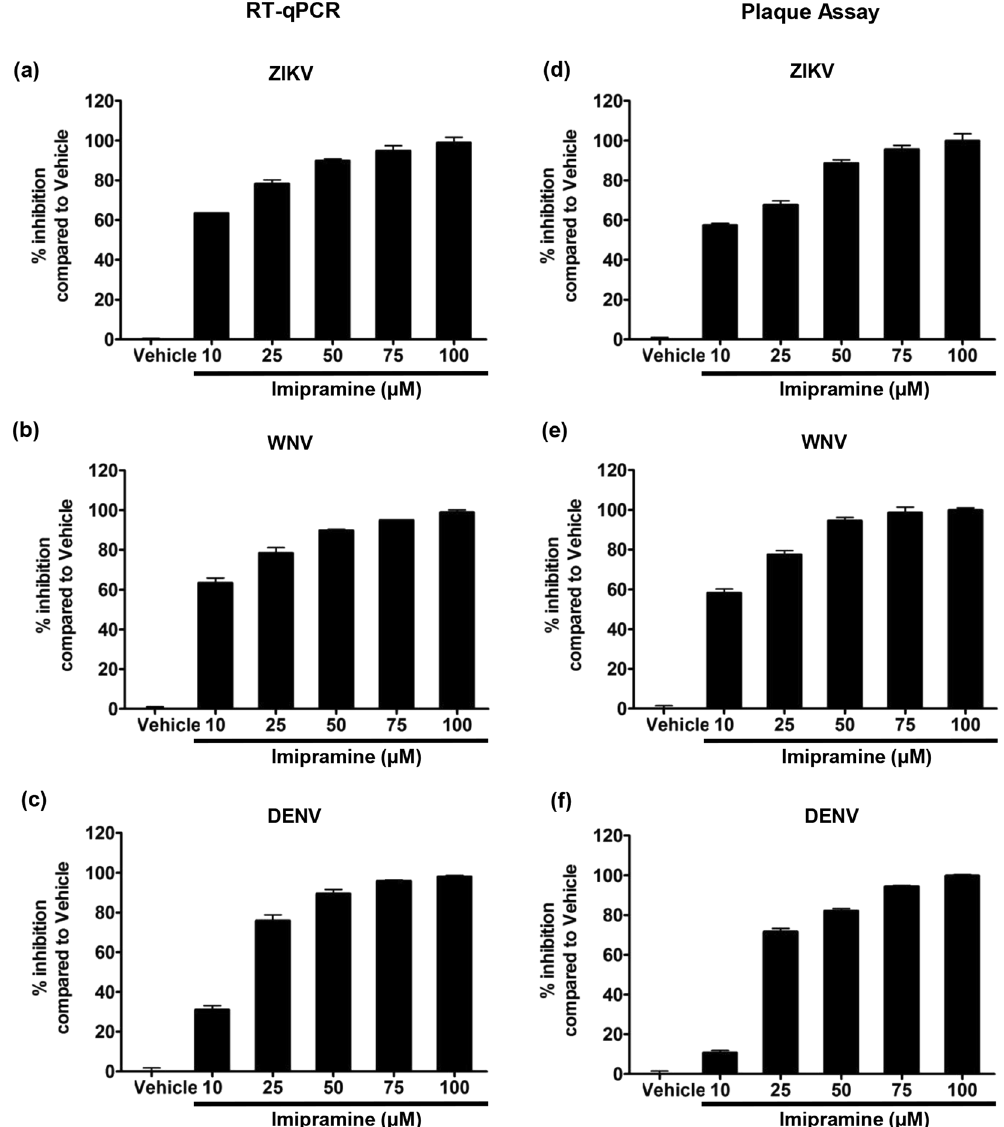
Figure 5. Imipramine inhibits Flavivirus replication in primary human skin fibroblasts. Human skin fibroblasts were pretreated with vehicle or imipramine at the indicated concentrations for 2 h before exposure to different Flaviviruses. Imipramine was present throughout the culture. After 48 h of culture, the presence of virus RNA in cells and infectious virus productions were quantified by RT-PCR and plaque assay, respectively. ( a , d ) ZIKV strain Pf13 (MOI 0.1) ( b , e ) WNV WT (MOI 0.1) ( c , f ) DENV-2 strain 16681 (MOI 0.5). The data represent mean ± SD from three independent